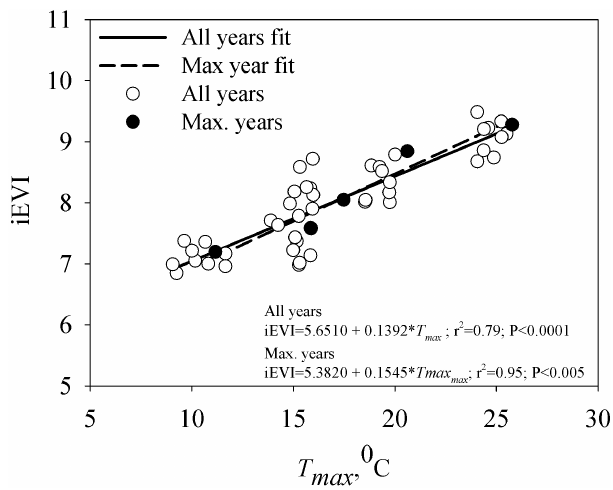
Figure 4. Comparison of iEVI differences between the extreme years and average of all other years of T max across sites. Extreme years mean that the years of T max anomaly are ≥ 1. The inset de- notes the average differences by biome type. DG, arid grassland sites (DE, JE, WG, and SR in Table 1); MG, mesic grassland sites (CP, SP, and LW in Table 1); TF, temperate forested sites (LR, MC, BC, and CF in Table 1); MF, Mediterranean forested site (CC). Dif- ferent letters indicate significant differences at P < 0 .